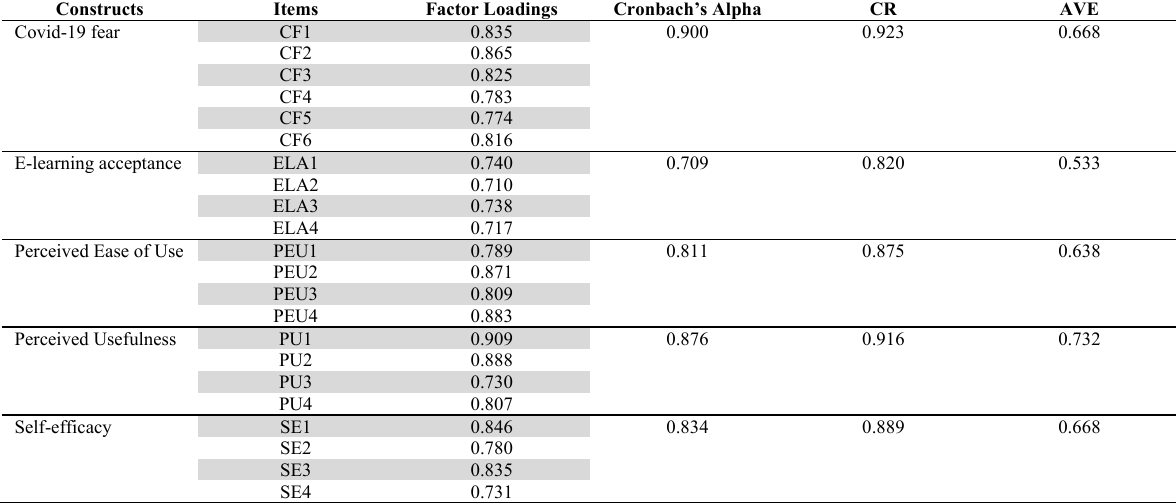
Convergent validity